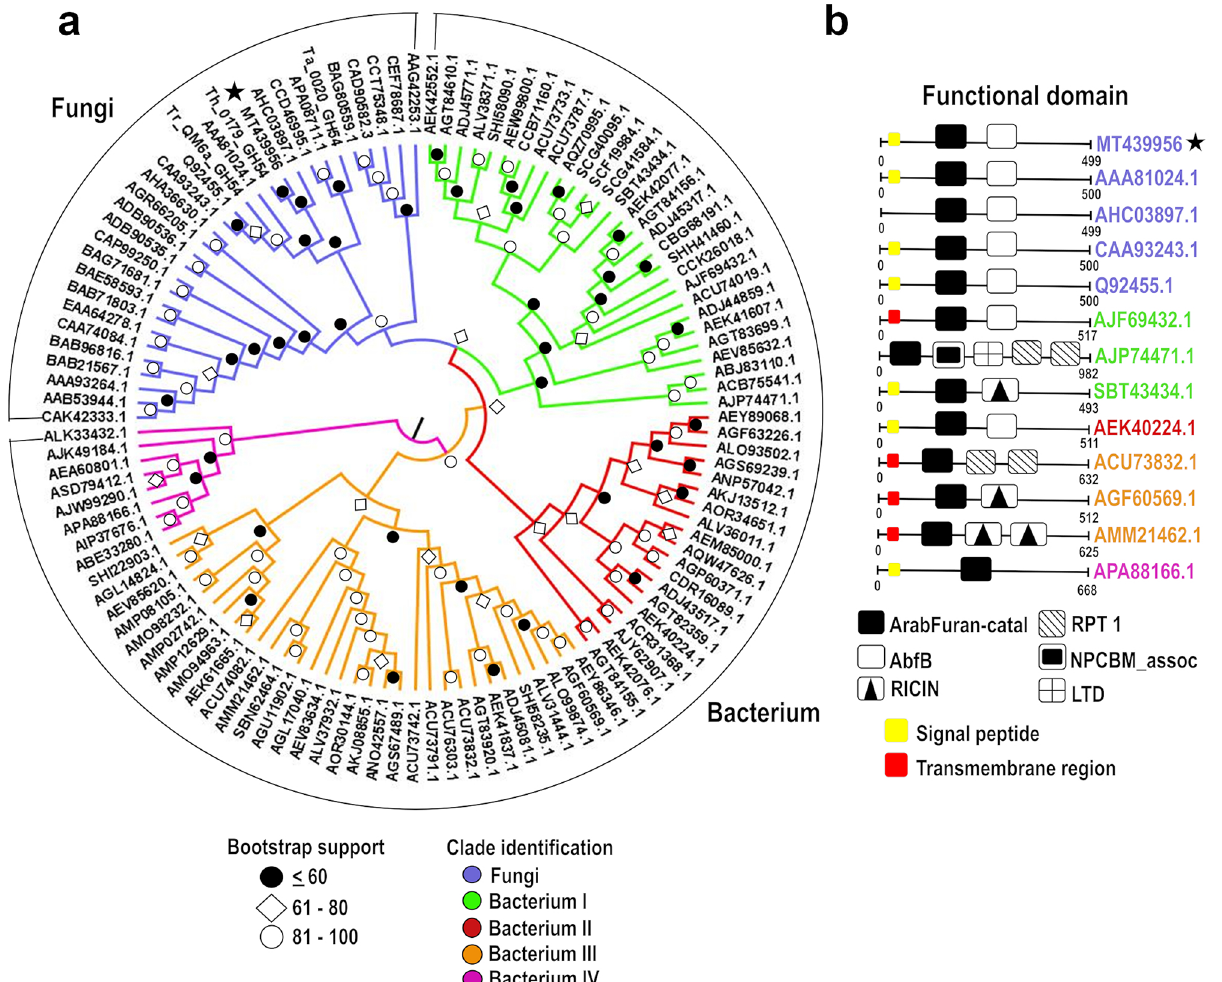
Figure 1. Phylogenetic analysis and sequence domains of the GH54 family. ( a ) Phylogenetic tree of the sequences. The star indicates the studied protein. Below the tree is a legend with the bootstrap values divided into ≤ 60%, 61–80 and 81–100. ( b ) Differences in the composition of domains in the sequences distributed in the groups. The identification of the groups is the same for A and